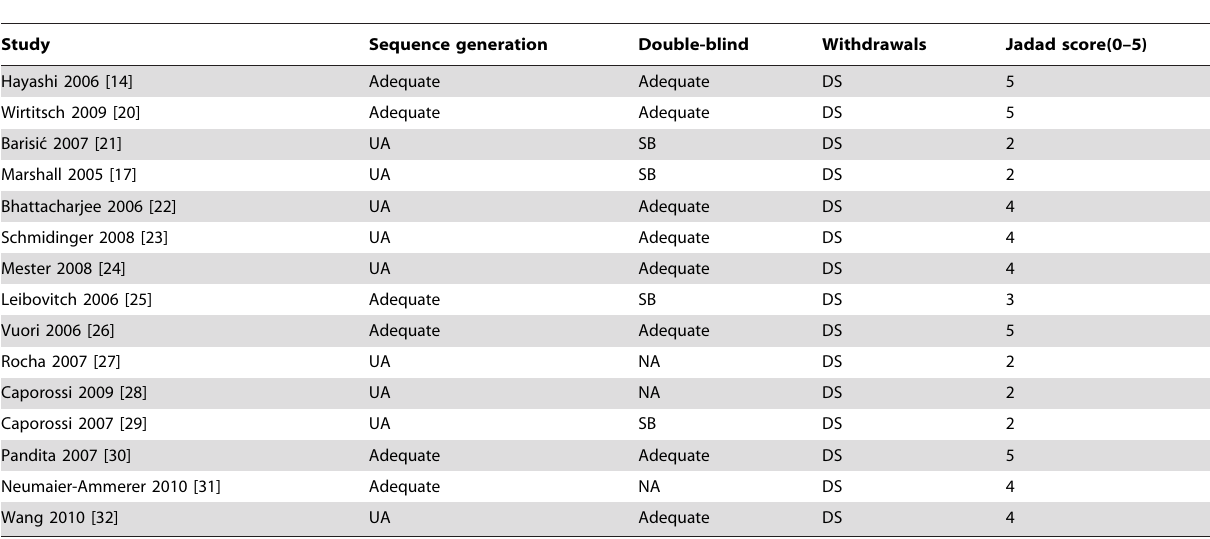
Table 3. Evaluation of the quality of RCTs included in the